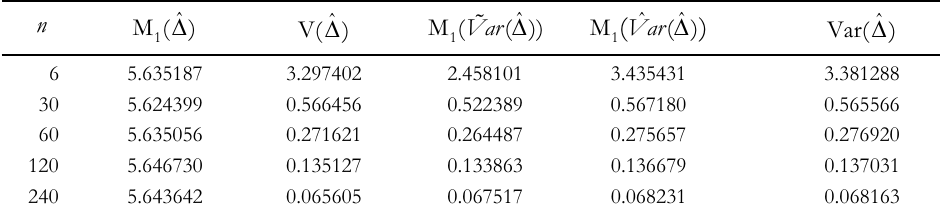
Simulation data for the estimation of ˆ Var( ) (cid:39) by and ˆˆ ( ) Var (cid:39) , sampling from the normal distribution (B=5000 samples)